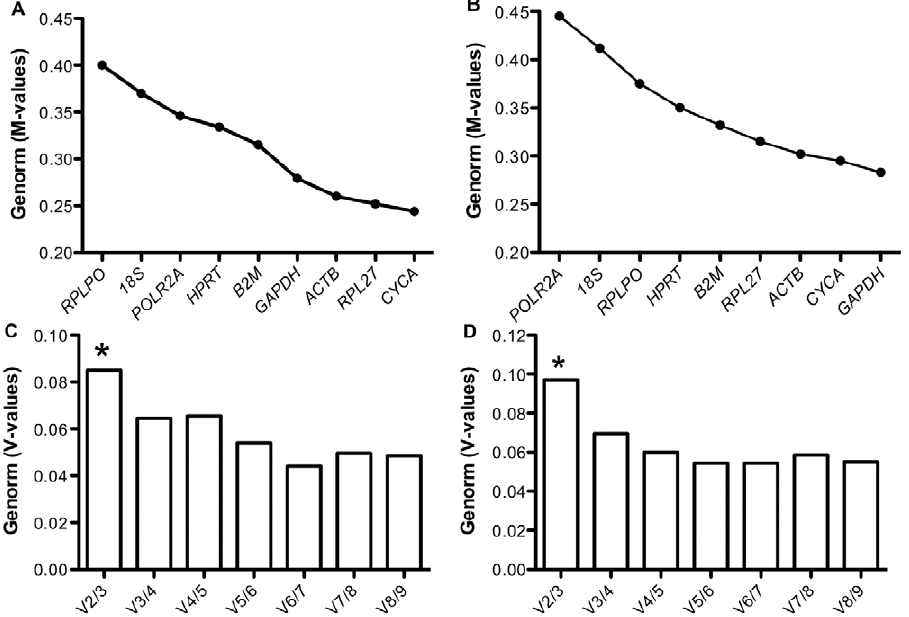
Figure 1. Validation of candidate genes using Genorm. Genorm M-values of the candidate genes for (A) n=12 and (B) n=33. Pairwise variation (V-values) of the candidate genes for (C) n=12 and (D) n=33. *represents the optimal number of reference genes required for the calculation of normalization factor.